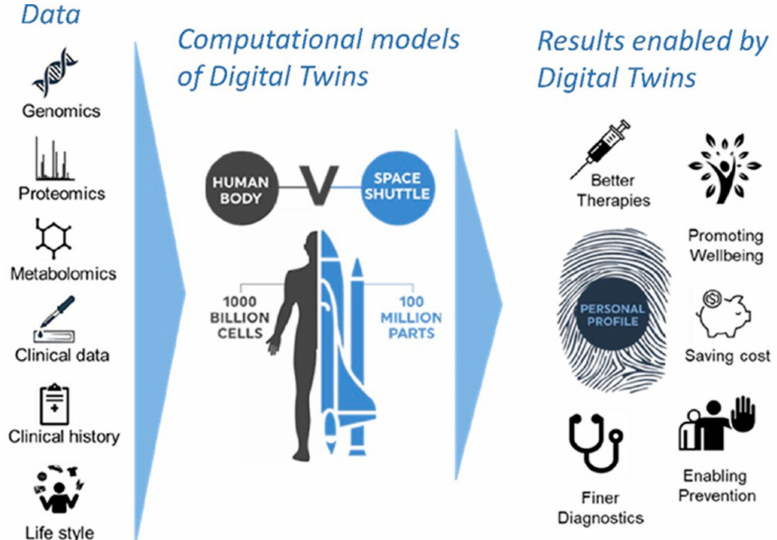
Figure 5. The Digital Twins concept. Integrating molecular, clinical, and imaging data through computational models will allow us to generate a digital twin of each patient. Treatments can be first tried on the digital twin and the best option selected for the treatment of the real patient. Likewise, personal prevention pathways can be designed. Both approaches optimize patient outcomes while minimizing costs as patients will not receive unnecessary